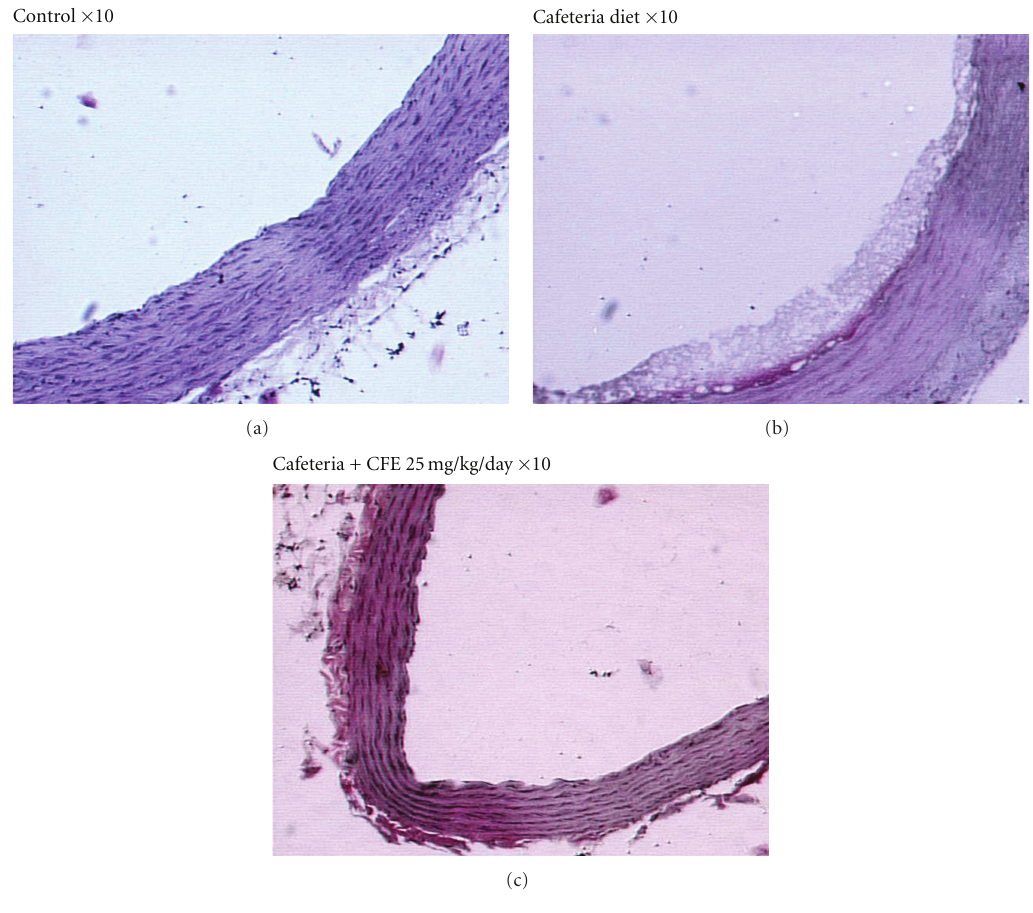
Figure 3: Antiatherogenic